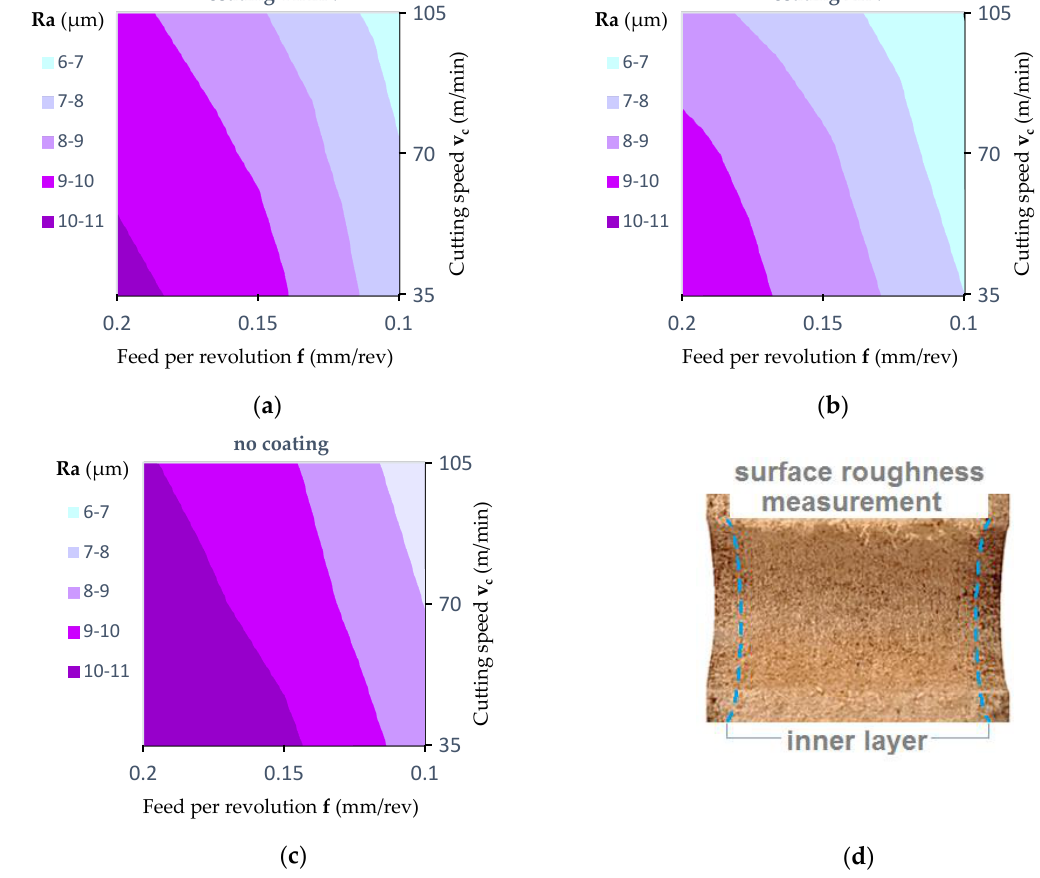
diagrams): ( a ) For a TiAlN coated drill; ( b ) for a ZrN coated drill; ( c ) for an uncoated drill; ( d ) 377